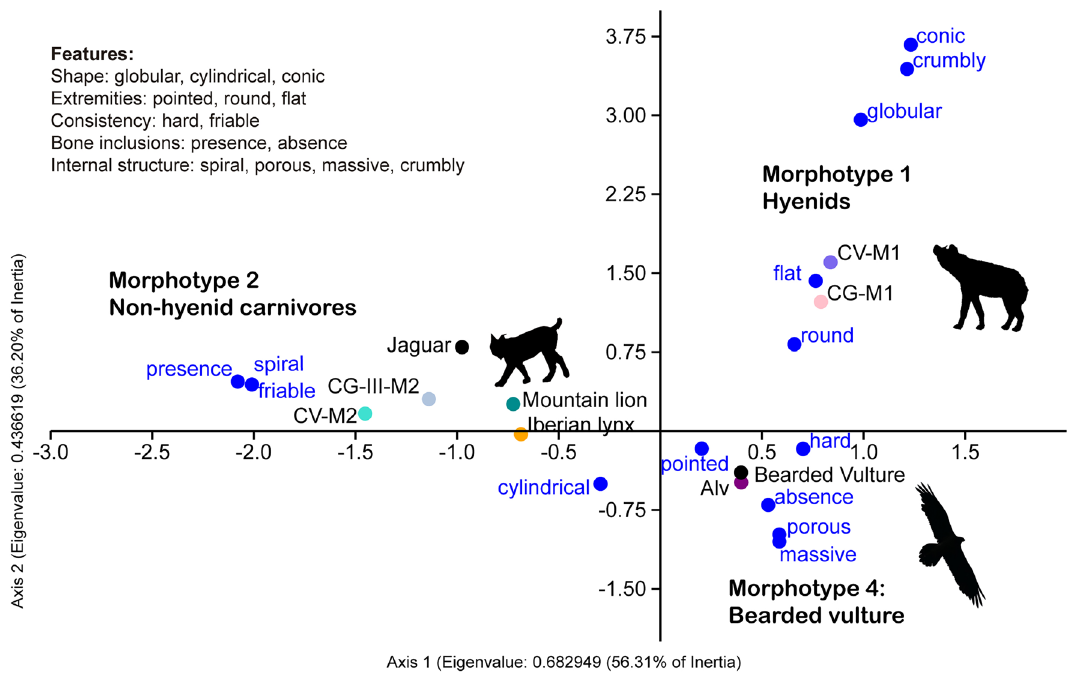
Figure 8. Correspondence analysis of the features (in blue) described for coprolites (ALV, CV: Cova del Coll Verdaguer and CG: Cova del Gegant) and modern-day scats (jaguar, mountain lion, Iberian lynx, bearded vulture). Source data from present study and previous work 22,23,30–32